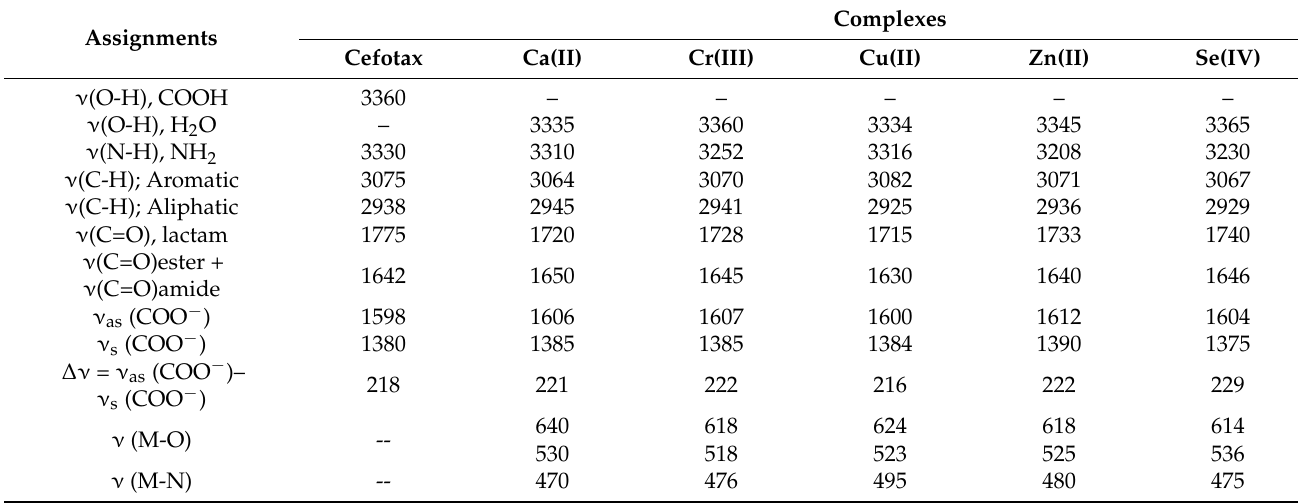
Table 2. Infrared assignments of cefotaxime and its metal